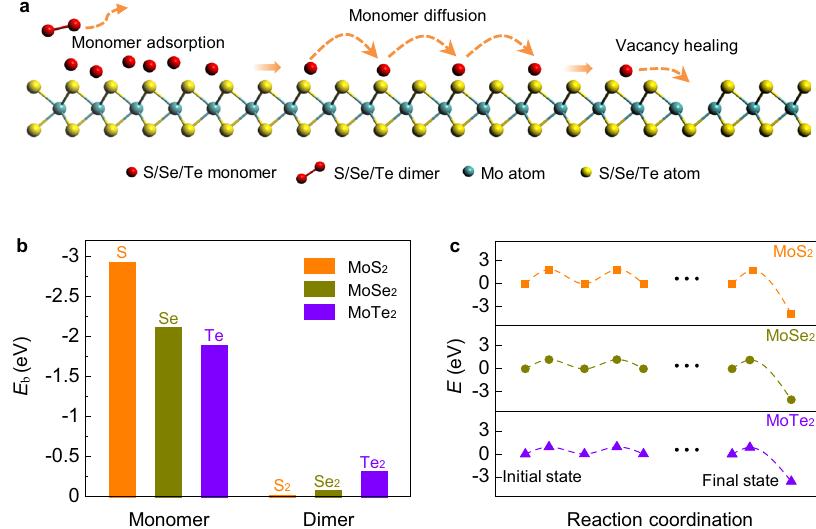
Fig. 4 Growth mechanism with chalcogen monomer supply in MoX 2 (X = S, Se, Te). a Schematic diagram of adsorption, diffusion, and vacancy healing of chalcogen monomer on MoX 2 surface. The orange dotted arrows denote the motion of chalcogen monomers or dimers. b The binding energies of monomers and dimers on MoX 2 surface. The much higher energy of monomers facilitates their better adsorption on the TMD surface than dimers. c The energy pro fi les of vacancy healing for MoX 2 surface by using chalcogen monomers. The relatively small energy barriers of chalcogen monomer diffusion and the highly exothermic reaction at the vacancy both accelerate the self-healing of MoX 2